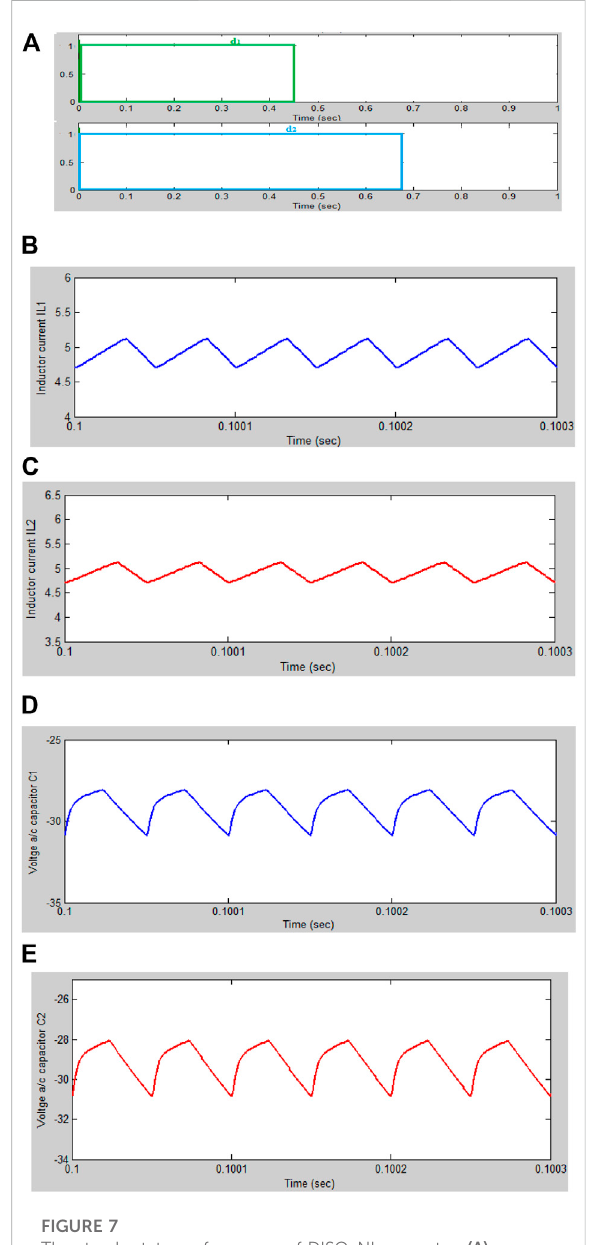
FIGURE 7 The steady state performance of DISO-NI converter. (A) Switching pulse to switches S1,S2. (B) Inductor L1 current. (C) Inductor L2 current. (D) Voltage across Capacitor C1. (E) Voltage across Capacitor